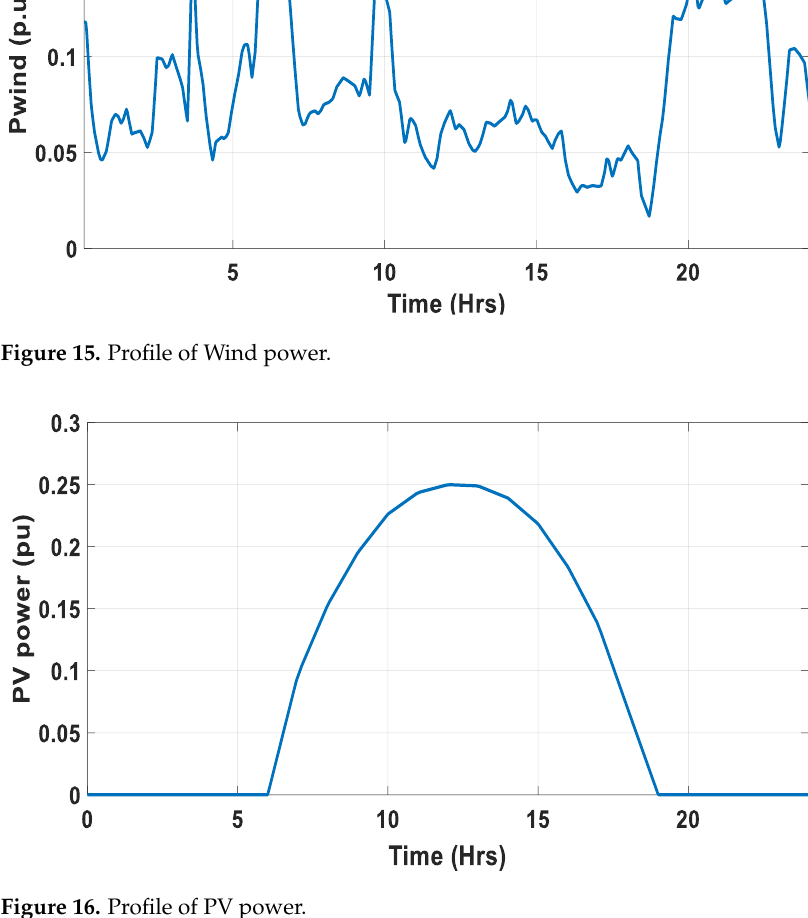
Figure 16. PV power variation. Figure 16. Profile of PV